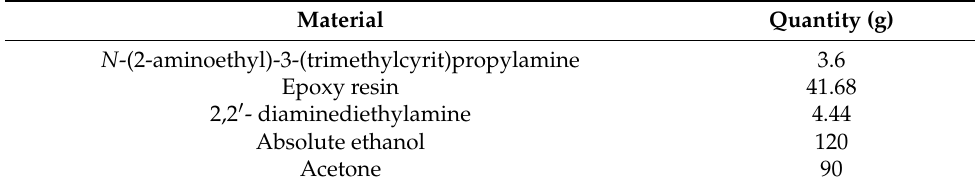
Table 4. The conditions for the composition of the coating.